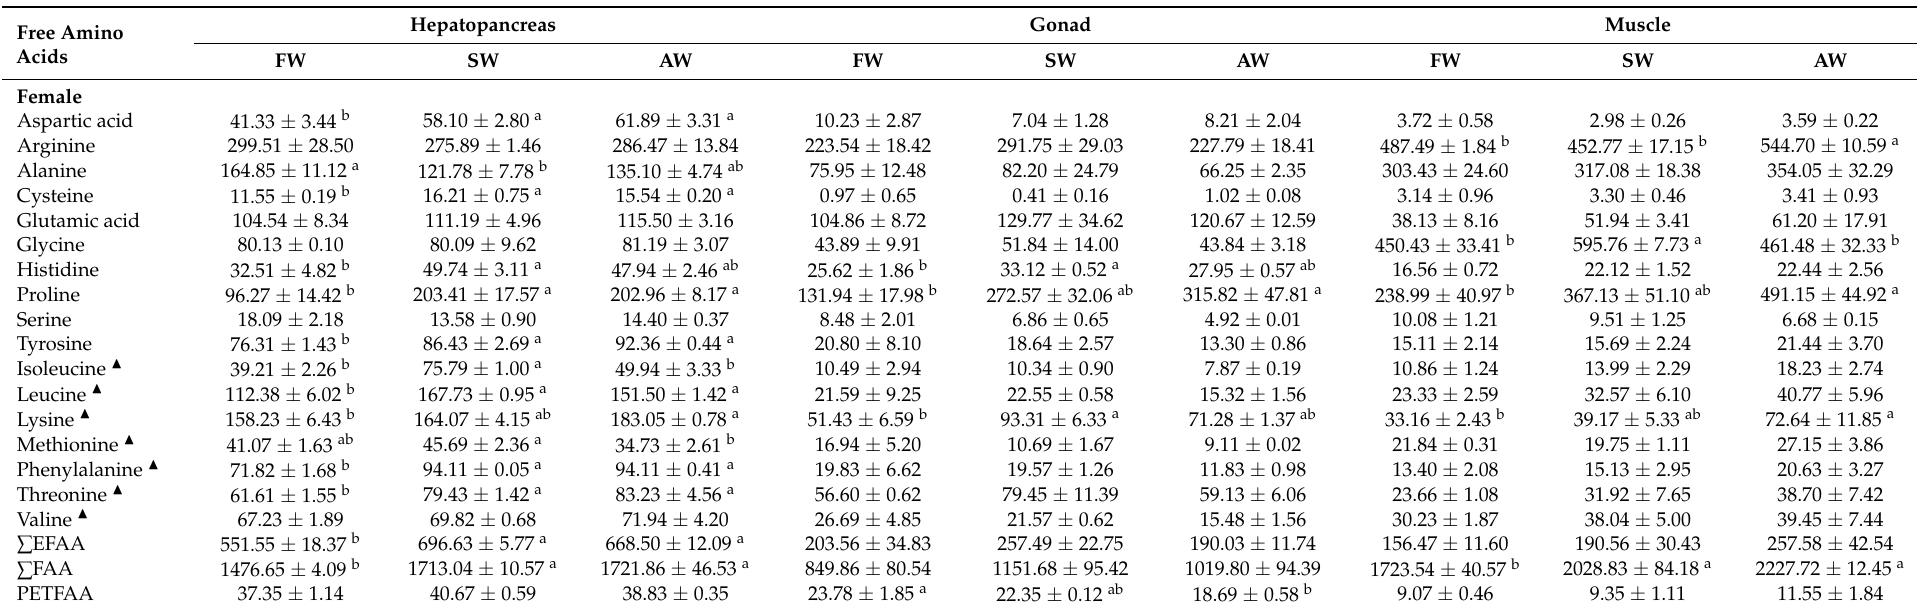
Table 3. Free amino acid composition in hepatopancreas, gonad, and muscle of adult Eriocheir sinensis fattening in different culture environments (mg/100 g, wet